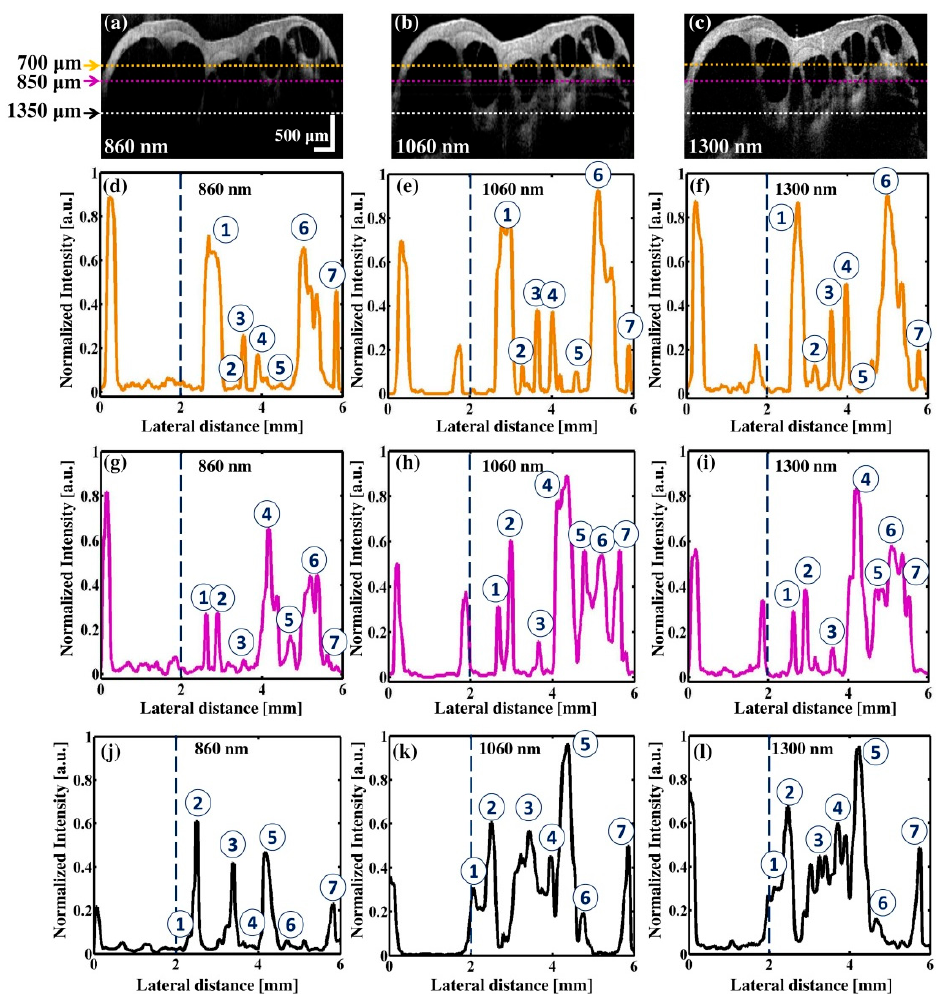
Figure 3. Cross-sectional images and the corresponding normalized transverse direction intensity profiles for each (700 μ m, 850 μ m, and 1350 μ m) depth range. ( a – c ) were acquired using 860 nm, 1060 nm, and 1300 nm OCT systems, respectively. The upper dotted line (in orange), middle dotted line (in magenta), and lower dotted line (in white) refer to depth levels of 700 μ m, 850 μ m, and 1350 μ m from the top range of the guinea pig cochlea specimen, respectively. Graphs ( d – f ) indicate transverse intensity fluctuation corresponds to the upper depth range (penetration depth at 700 μ m). Graphs ( g – i ) indicate transverse intensity fluctuation corresponds to the middle depth range (penetration depth at 850 μ m). Graphs ( j – l ) indicate transverse intensity fluctuation corresponds to the lower depth range (penetration depth at 1350 μ m). The inset numbers ( ① ~ ⑦ ) illustrate the seven uniform points of interest considered for the quantitative analysis of each depth range.